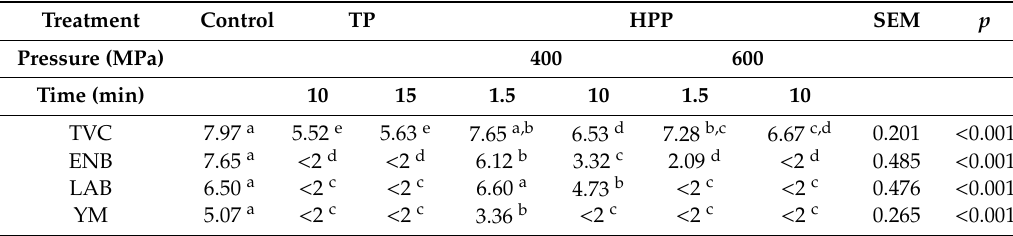
Table 4. E ff ect of di ff erent treatments on the microbial levels (log colony-forming units (CFU) / g) of black soldier fly